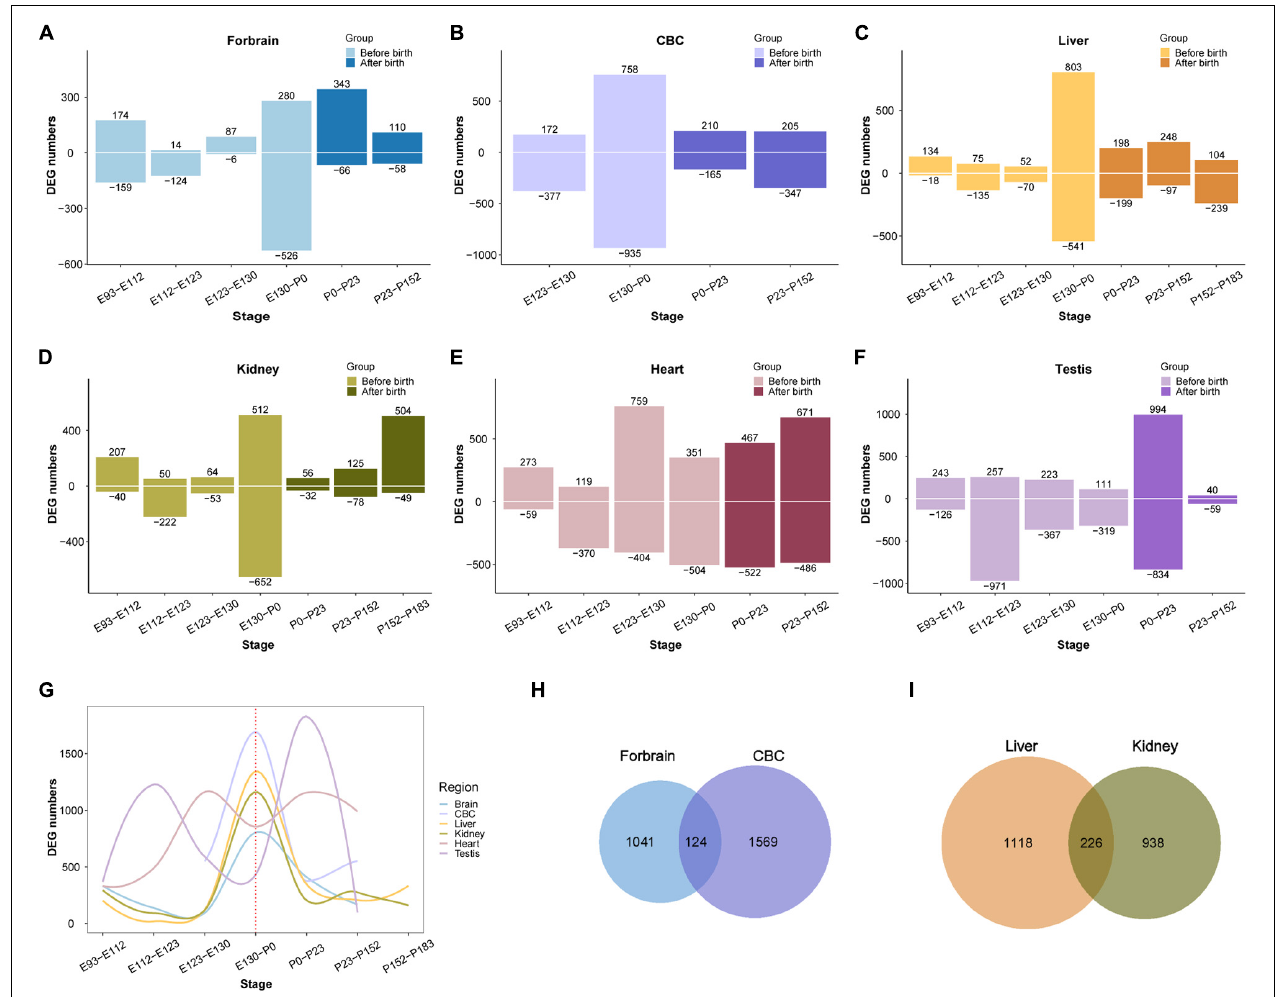
FIGURE 3 | Organ DEG distribution in rhesus macaques. (A–F) Show the distribution of DEGs across development in forebrain, cerebellum (CBC), liver, kidney, heart, and testis. The x -axis shows age, the y -axis shows the number of DEGs in each period. Positive and negative indicate the number of upregulated and downregulated DEGs, respectively. (G) The distribution of overall DEGs across development in the 6 organs, the first regulatory peak starts mostly before birth. (H) The overlap of DEGs between ForeBrain and cerebellum (CBC). (I) overlap of DEGs between liver and kidney.